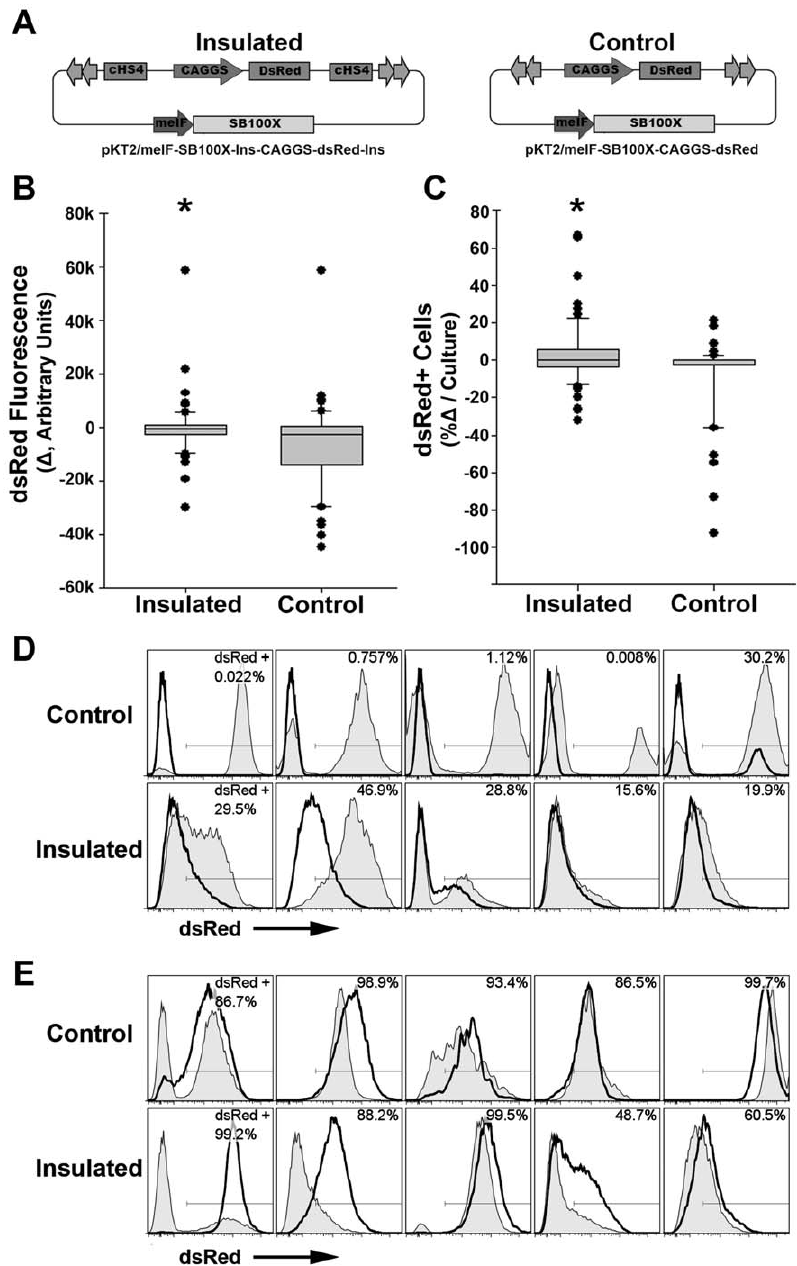
Figure 7. cHS4 insulator elements maintain long-term DsRed expression. ( A ) SB vectors insulated by cHS4 elements or non-insulated control SB vectors. CAGGS promoters with DsRed reporter transgenes and hyperactive SB transposase gene SB 100X with meIF promoter are indicated. IR/DRs of SB are denoted by two short consecutive arrows. ( B ) Change of mean fluorescent intensity of DsRed between 2–4 weeks and 13– 15 weeks after transfection displayed as a box plot showing 10 th , 25 th , 50 th , 75 th , and 90 th percentiles within each population with outliers shown individually. * indicates p , 0.05, Mann-Whitney U test. ( C ) Change in the % DsRed + cells in culture between 2–4 weeks and 13–15 weeks displayed as box plot. * indicates p , 0.05, Mann-Whitney U test. ( D ) Examples of progressive silencing of DsRed demonstrated by profiles from the 5 clones with the greatest percent loss in DsRed expression for each vector. Shaded histogram, 2–4 weeks after transfection; solid histogram, 13–15 weeks after transfection. ( E ) Examples of positive shift of DsRed expression demonstrated by five clones with the greatest gains in DsRed expression for each vector term culture. Shaded histogram, 2–4 weeks after transfection; solid line, 13–15 weeks after transfection.